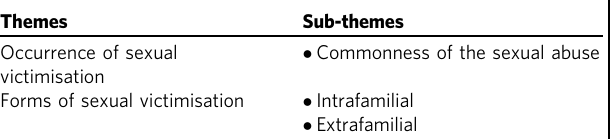
Table 1 Summary of themes and